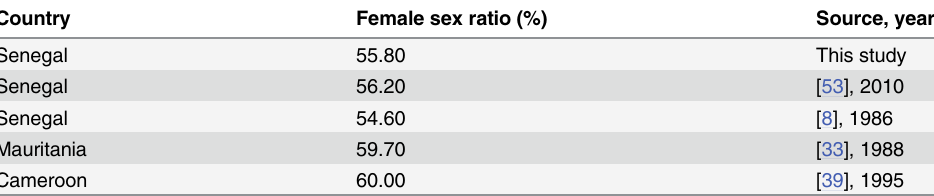
Table 6. Sardinella maderensis sex ratios based on the published literature for West Africa. Country